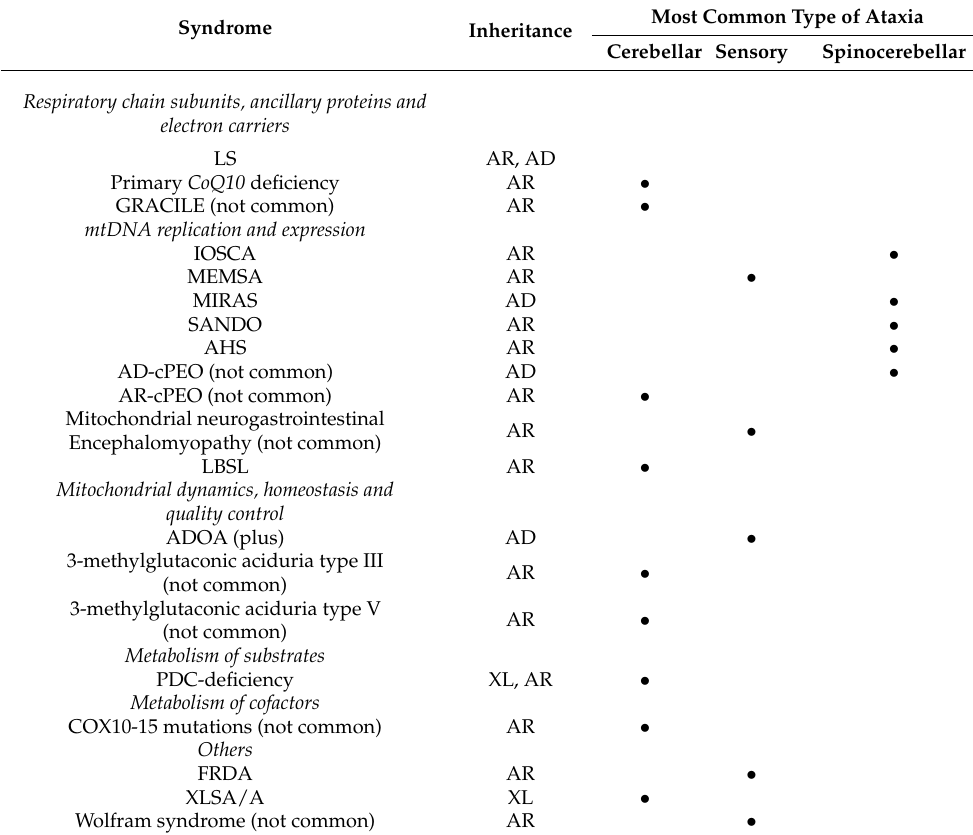
Table 3. Ataxia in nDNA-related